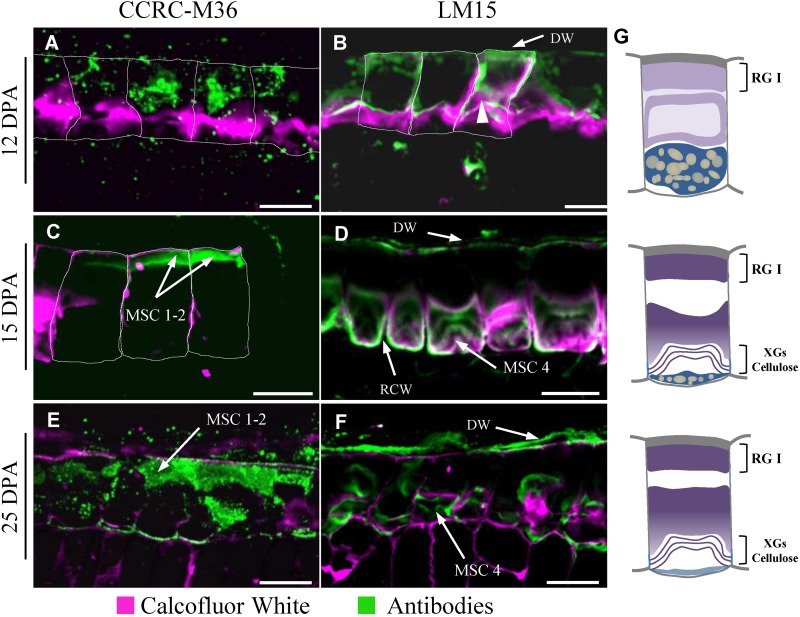
Polarized distribution of rhamnogalacturonan I and xyloglucans in flax MSCs. Seed coat sections from RIL 44 at 12 DPA (A,B), 15 DPA (C,D) and 25 DPA (E,F) labeled with CCRC-M36 (A,C,E) and LM15 (B,D,F) antibodies recognizing unbranched RG I and xyloglucan epitopes, respectively. Calcofluor White, which stains both cellulose and other β-1,4-glycans, was used to visualize the cell walls. The outlines of the MSCs were manually drawn (white dashed lines) since distal and radial walls labeling are too weak, especially at 12 and 15 DPA. (G) Schematic view of transversal flax seed coat sections at 12 DPA (top panel), 15 DPA (middle panel) and 25 DPA (bottom panel). The putative chemical composition is reported in each MSC layer. DW, distal primary cell wall; RCW, radial cell wall. Bars = 40 μm.